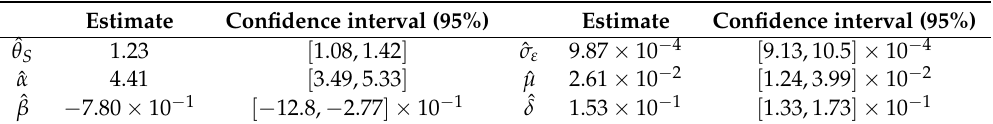
Table 1. Estimated parameters for the electricity spot price process.